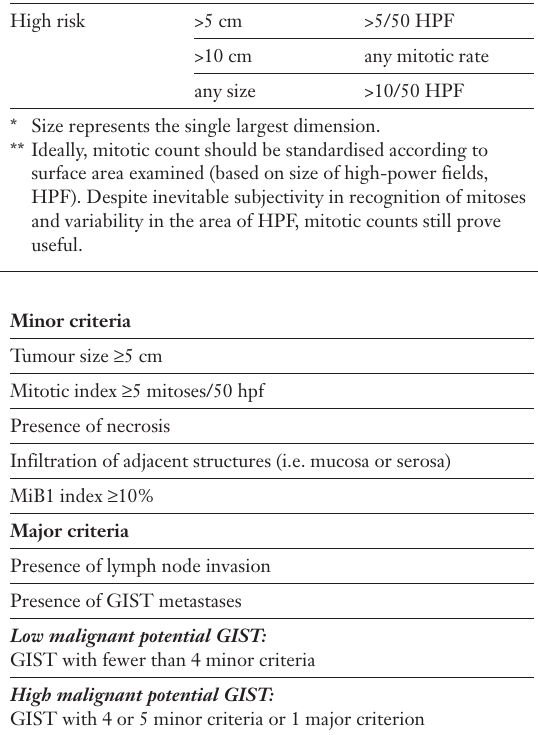
Proposed approach for assessing risk of aggressive behavior of GIST (adapted from Fletcher et al. [6]).